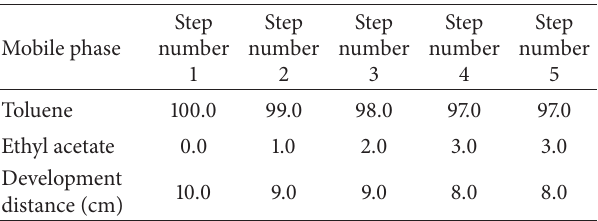
Table 2: The program used for five-step gradient elution for the development in second dimension for Thymi Oleum . Mobile phase Figure 1: 1D separation of Juniperi Oleum compounds. The mobile